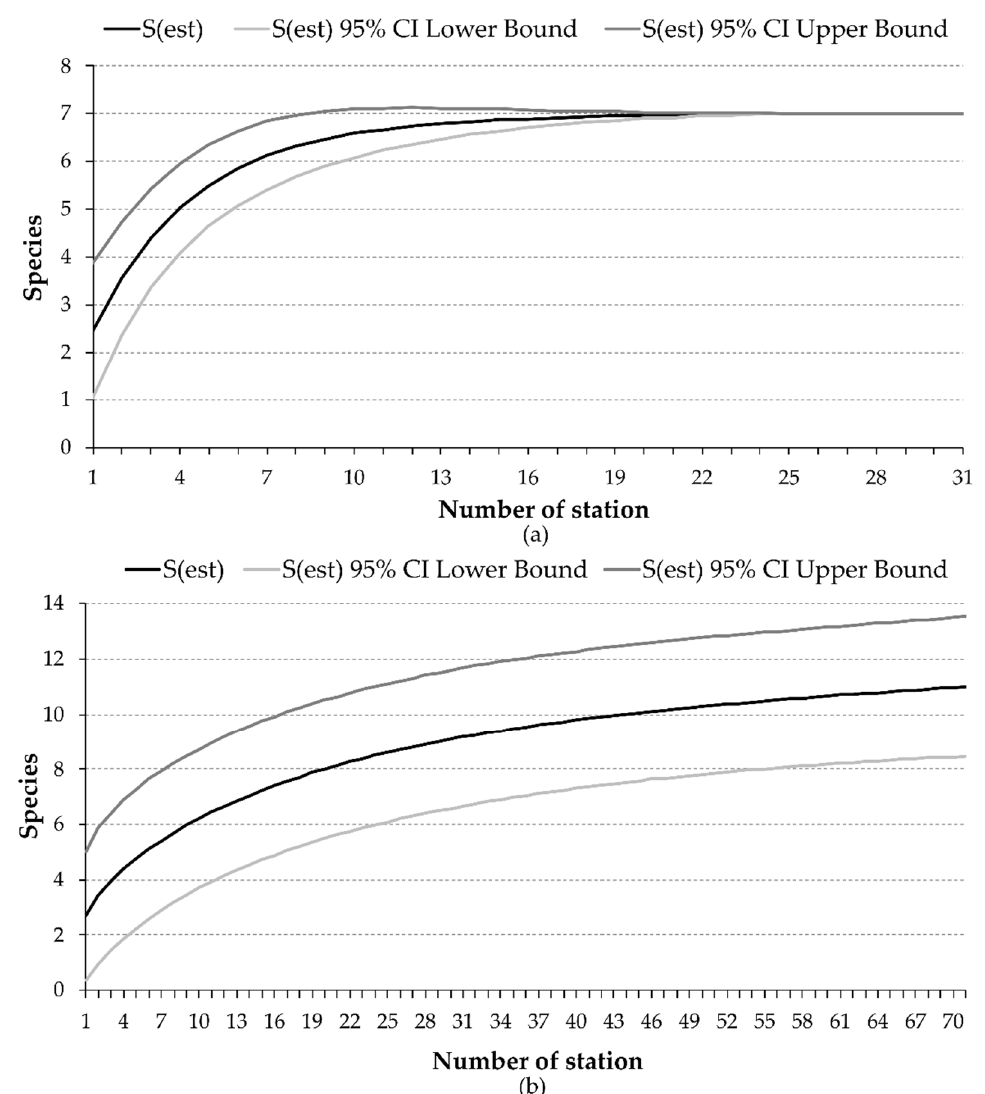
Figure 2. Cumulative curves for total deployments in the southern Adriatic Sea and north-western Ionian Sea using baited lander ( a ) and longline ( b ).